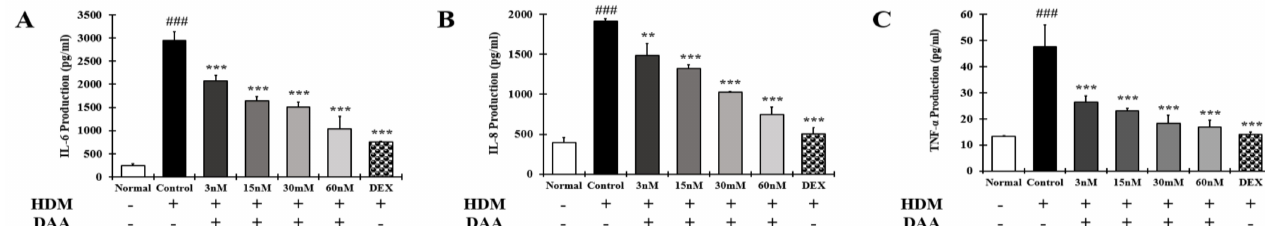
Figure 14. Effect of DAA on AD-related cytokine and chemokine secretion in EOL-1cells. The levels of IL-6 ( A ), IL-8 ( B ), and TNF- α ( C ) in the supernatant of EOL-1 cells were analyzed by ELISA. The results are expressed as the mean ± SD (n = 4). ### p < 0.001 vs. normal. ** p < 0.01 and *** p < 0.001 vs. control. DAA was used at 3 nM, 15 nM, 30 nM, and 60 nM. DEX, the positive control, was used at 2 nM.